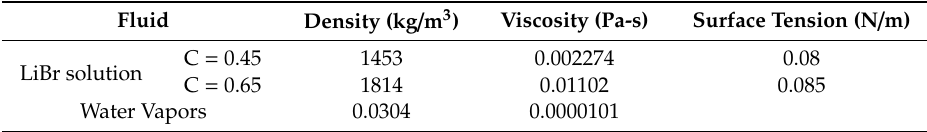
Table 1. Thermophysical properties of LiBr solution and water